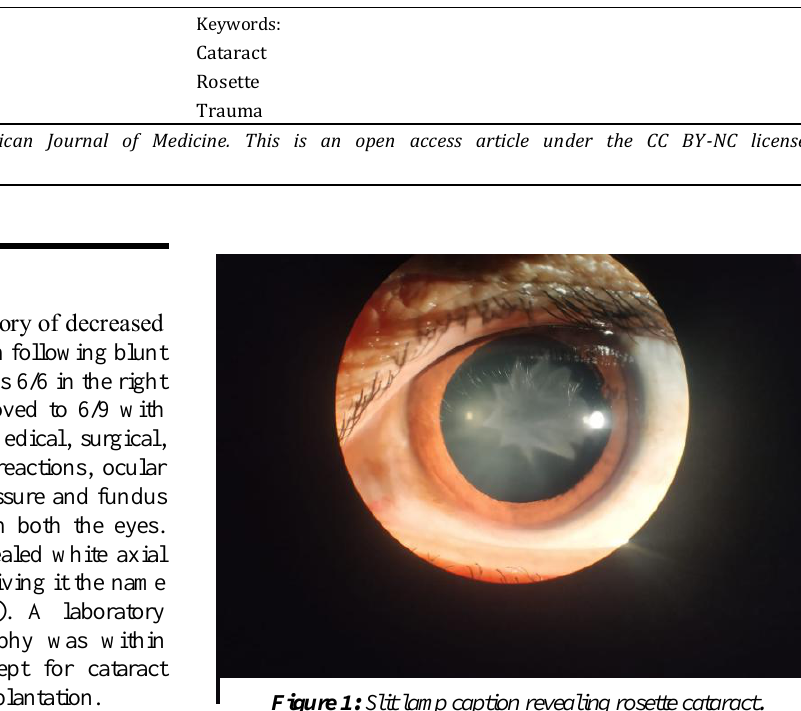
Figure 1: Slit lamp caption revealing rosette